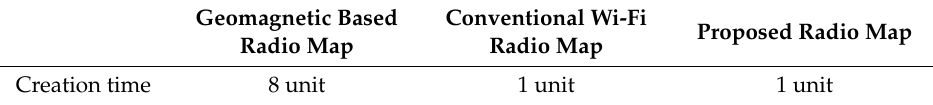
Table 1. Comparison of generation time of radio map in training phase (same sampling